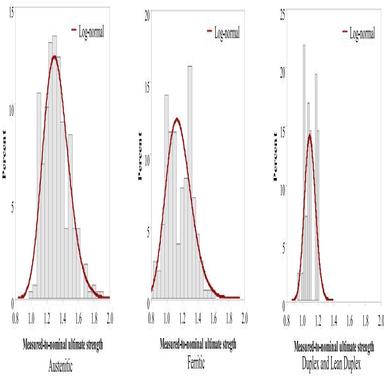
Histograms of ultimate strength fu for different cold-formed stainless steel types.